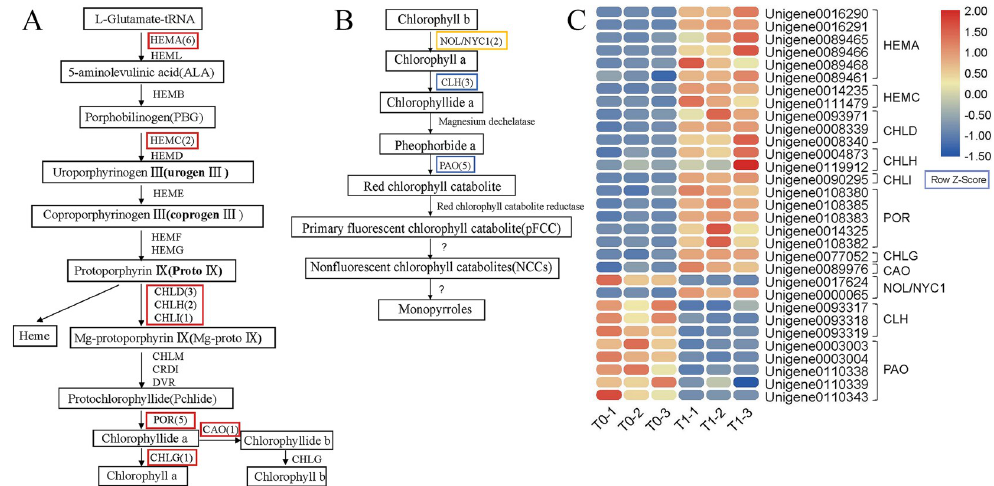
Fig 5. Chlorophyll metabolism pathway and heat map of Pennisetum setaceum ‘Rubrum’. (A) Chlorophyll biosynthesis pathway [5, 6], (B) chlorophyll degradation pathway [28–30], and (C) heat map of pathway-related differentially expressed genes. The red box indicates upregulated genes, the blue box indicates downregulated genes, and the orange box indicates genes that are both upregulated and downregulated in T1 stage.